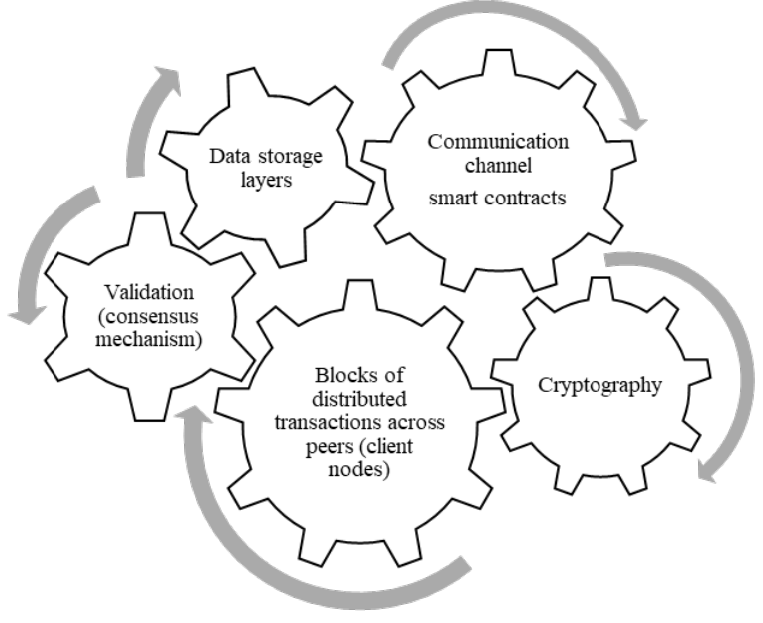
Figure 1. Blockchain features.